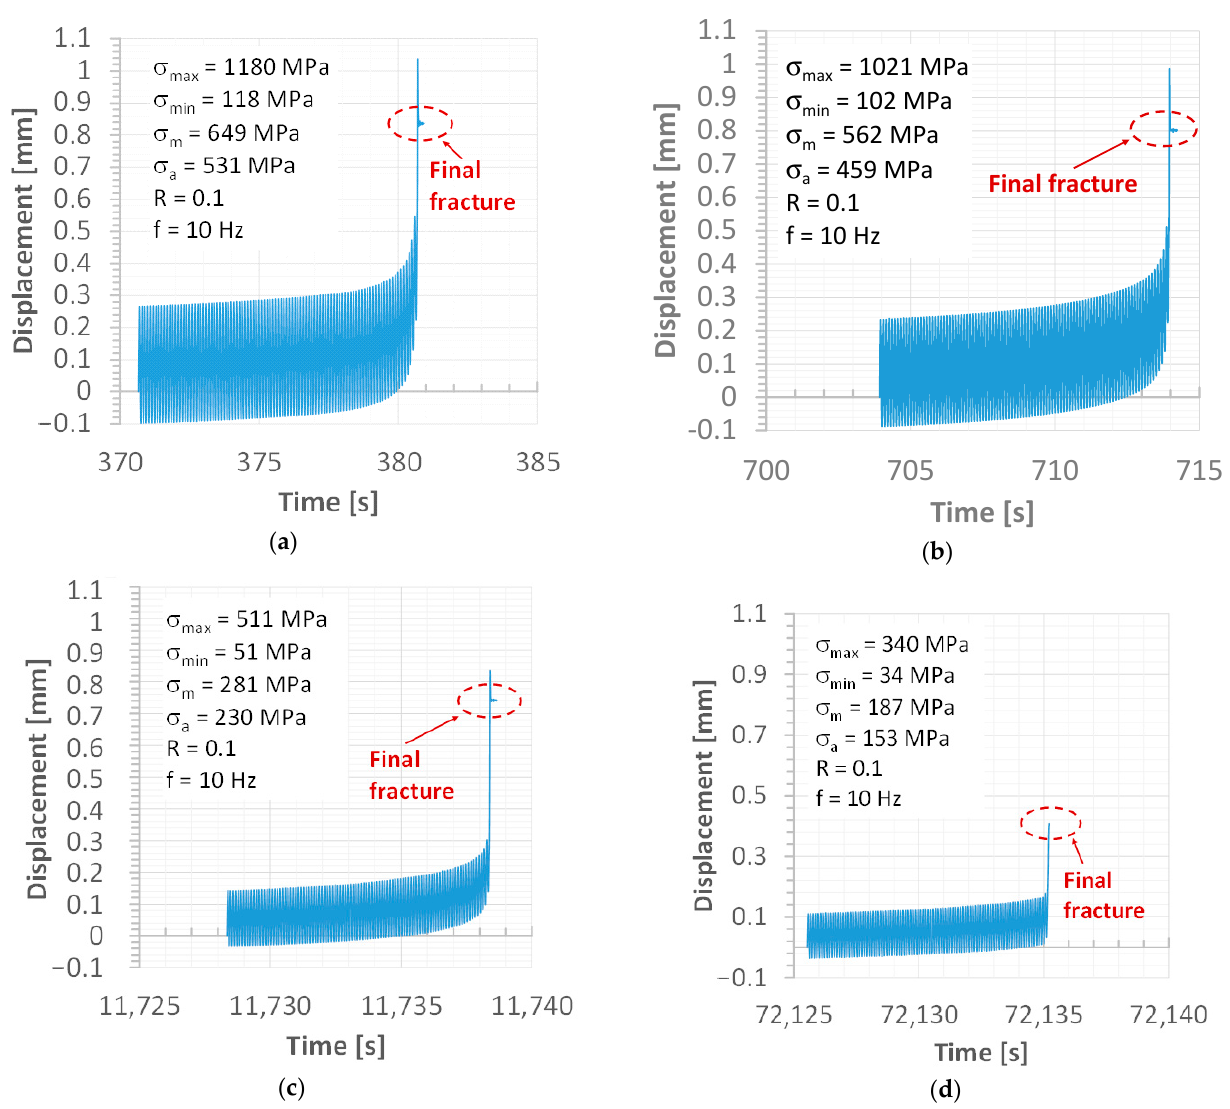
Figure 12. Displacement versus time at the finale stage of the fatigue test for the following values of maximum stress: ( a ) 1180 MPa, ( b ) 1021 MPa, ( c ) 511 MPa and ( d ) 340 MPa.